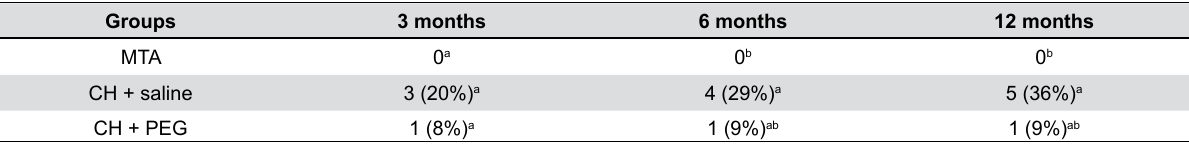
Table 3- Inter-radicular bone destruction radiographically observed for MTA, CH+saline and CH+PEG pulpotomies at 3-, 6-, and 12-month follow-up Groups